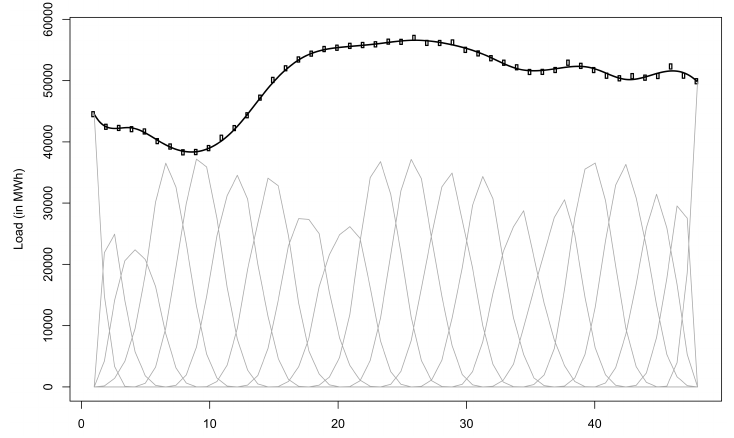
Figure 1. Illustration of the representation of a daily load curve (thick line) by a rank 20 B-spline bases (thin